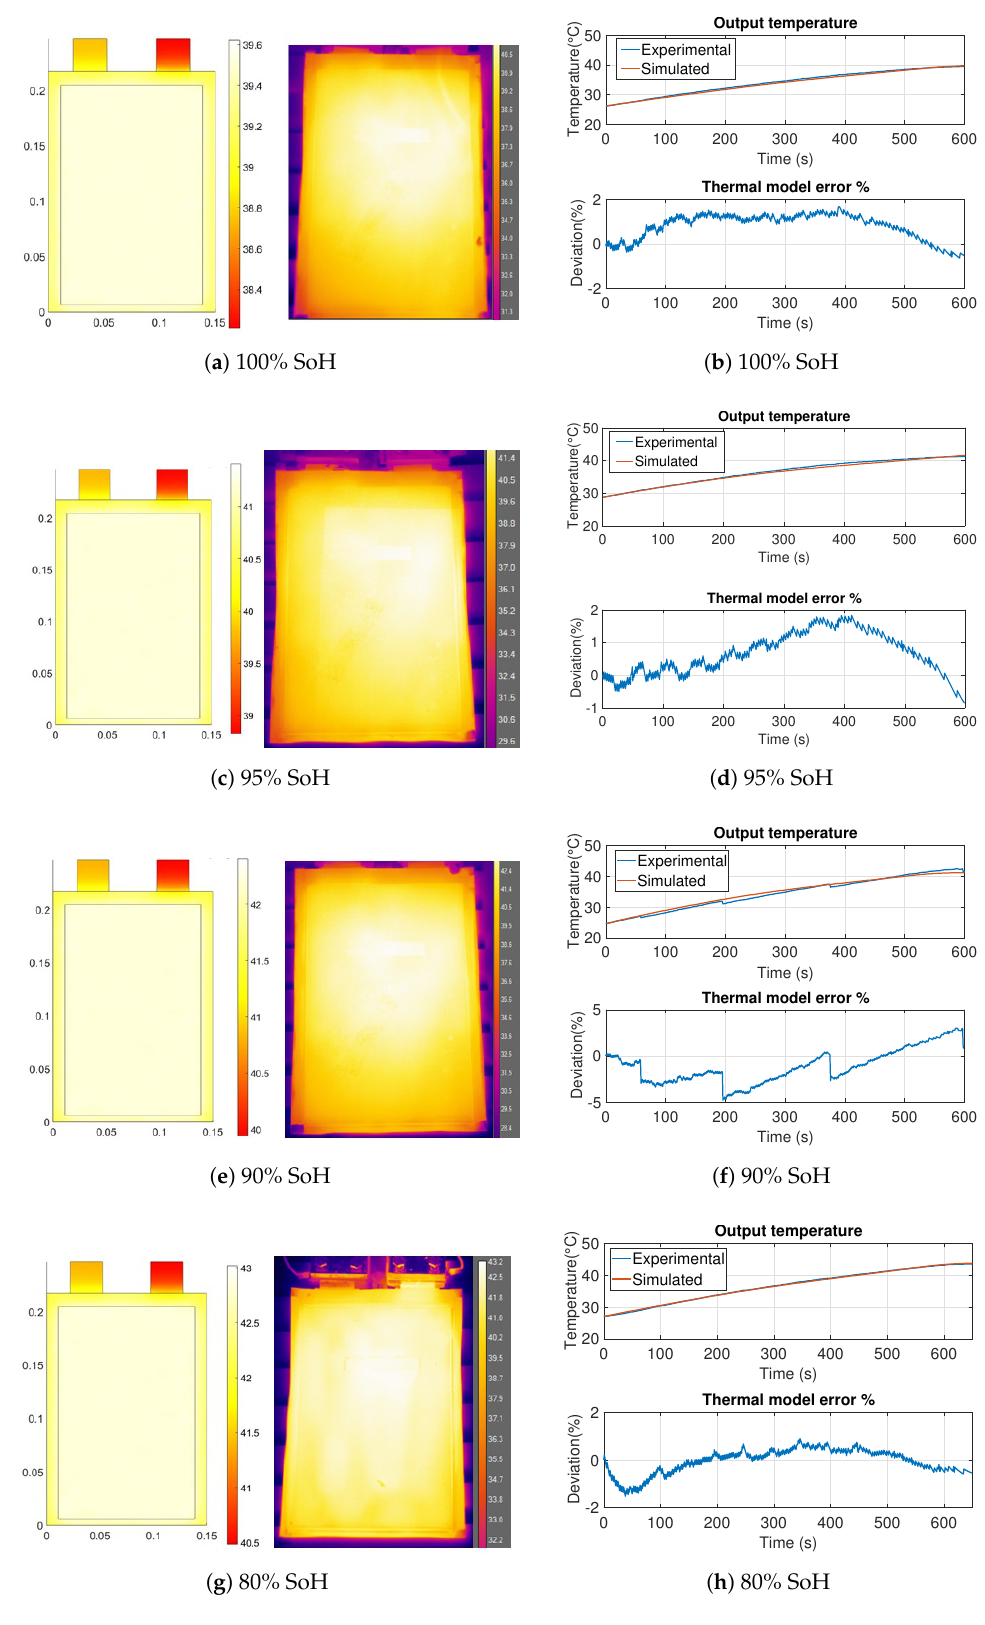
Figure 7. ( left ) Three-dimensional thermal image validation with 3D simulations; ( right ) one-dimensional validation measurements vs.